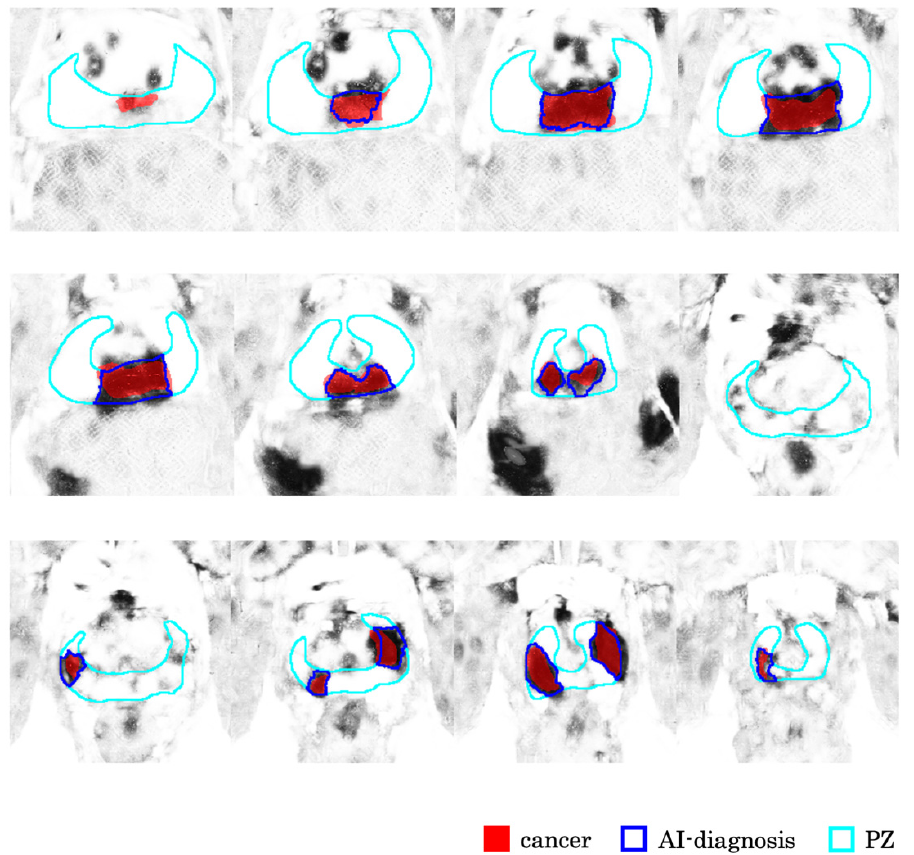
Figure 3. Examples of AI diagnosis (case 13). AI-diagnosed regions correspond approximately to true cancer. Cancer regions showed red. AI-diagnosed regions and peripheral zones were outlined by blue and cyan lines, respectively.